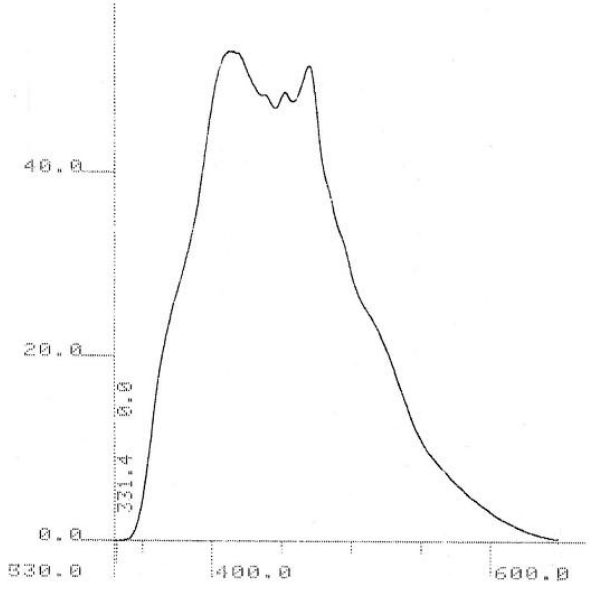
Figure 3. The fluorescent spectrum of 1 .